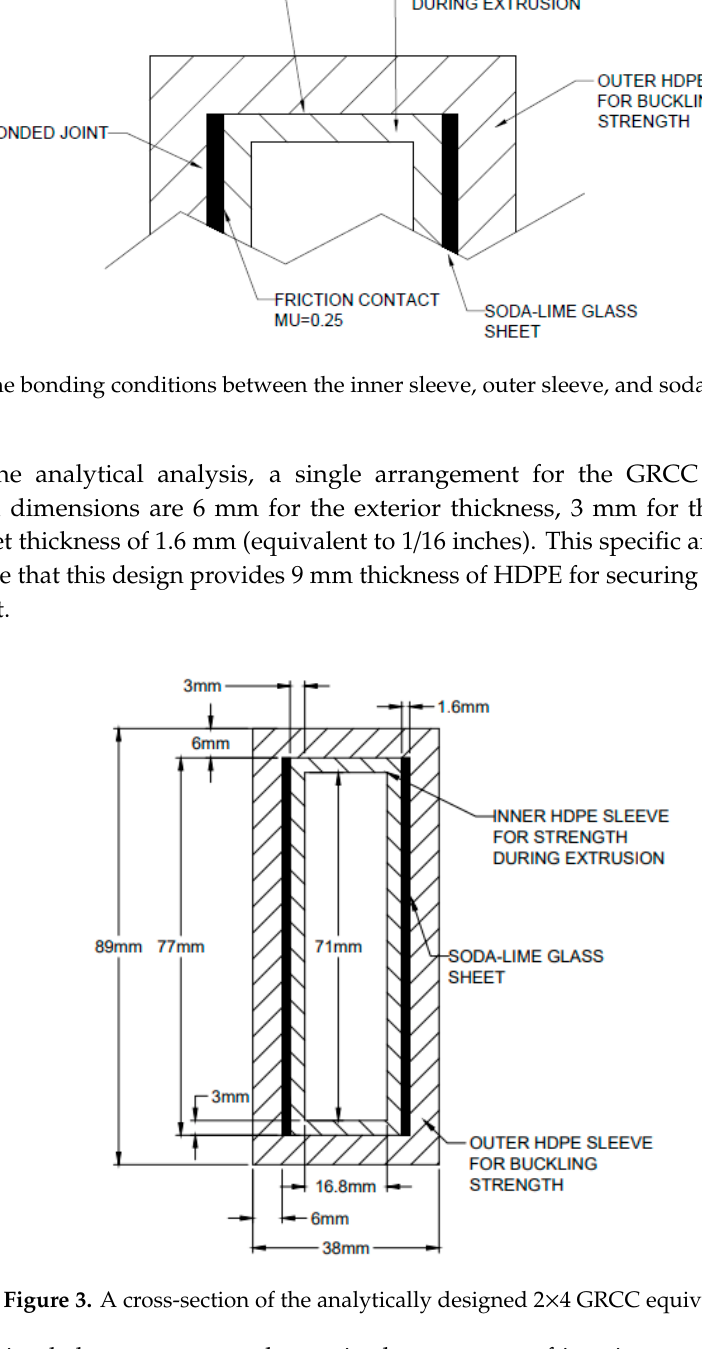
Figure 3. A cross-section of the analytically designed 2×4 GRCC equivalent.